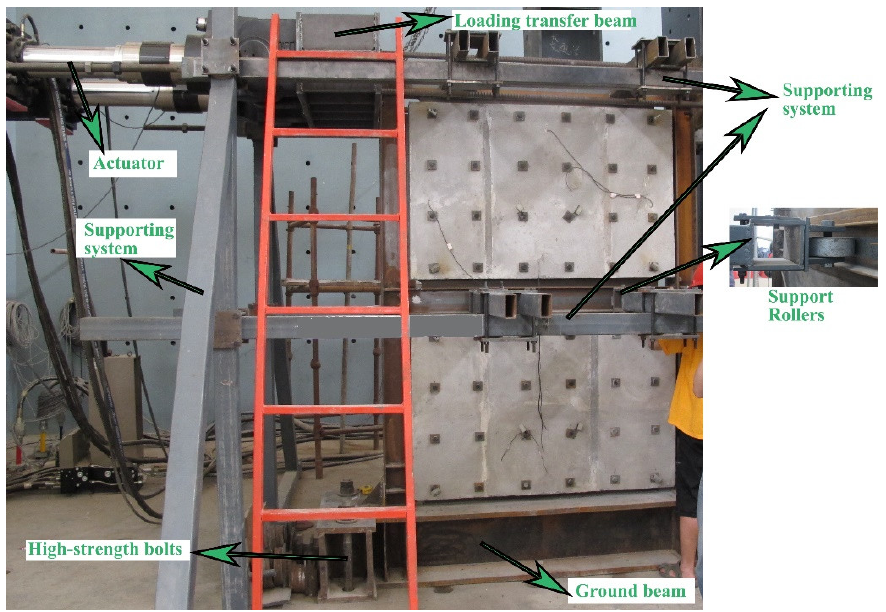
Figure 5. Test setup of a specimen of SPCSW.